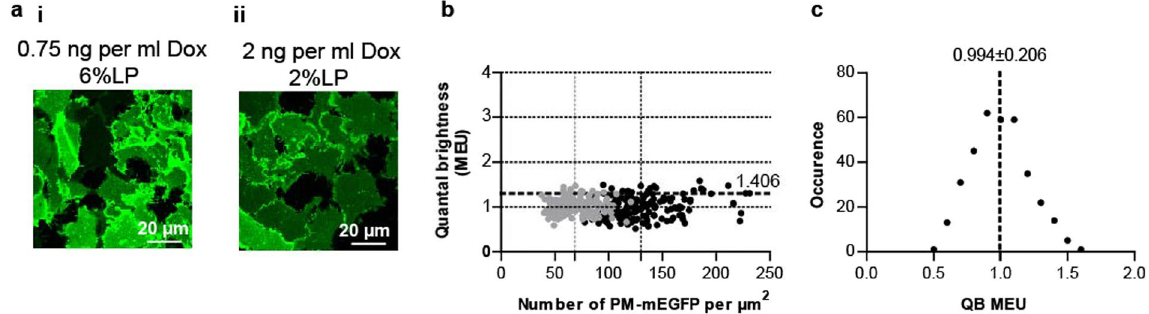
Figure 2. Determination of monomeric QB. Flp-In T-REx 293 cells harboring P + M-mEGFP were treated with 0.75 ng.ml − 1 or 2 ng.ml − 1 doxycycline (Dox) for 16 h. ( a ) Confocal images from the basolateral membrane of these cells were collected at 6% (i) or 2% (ii) laser power respectively. Scale bar = 20 μ m. ( b ) QB MEU were assessed in individual RoI and plotted against the number of P + M-mEGFP per µ m 2 at the basolateral surface. Grey circles , cells treated with 0.75 ng.ml − 1 Dox; black circles cells treated with 2 ng. ml − 1 Dox. The horizontal dotted line (1.406 MEU) corresponds to mean + 2 S.D. Values lower or equal to this (95.44% of the data points) were scored as ‘monomeric’ (see ‘Experimental’). Vertical dotted lines provide mean particle number per μ m 2 for the two conditions described above. ( c ) QB MEU values obtained with laser power set at 2% and 6% were combined and binned. Analysis indicated values to be normally distributed.